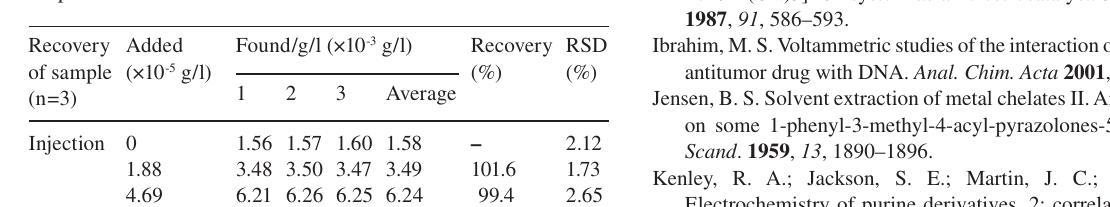
Table 1 Results for determinations of GU in the Aciclovir Dispersible Tablets